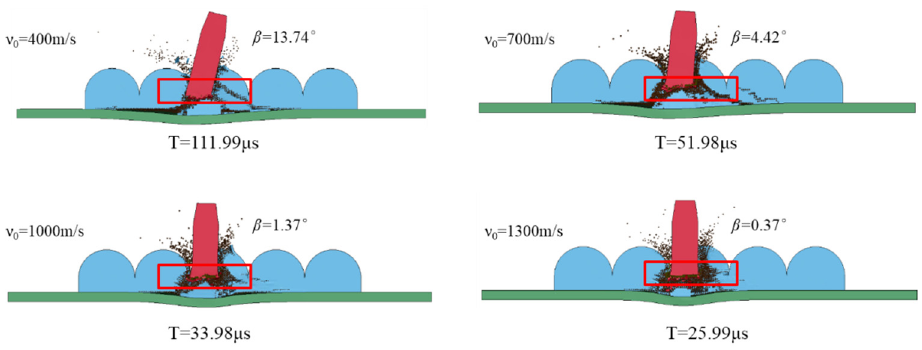
Figure 25. Penetration under different working conditions.